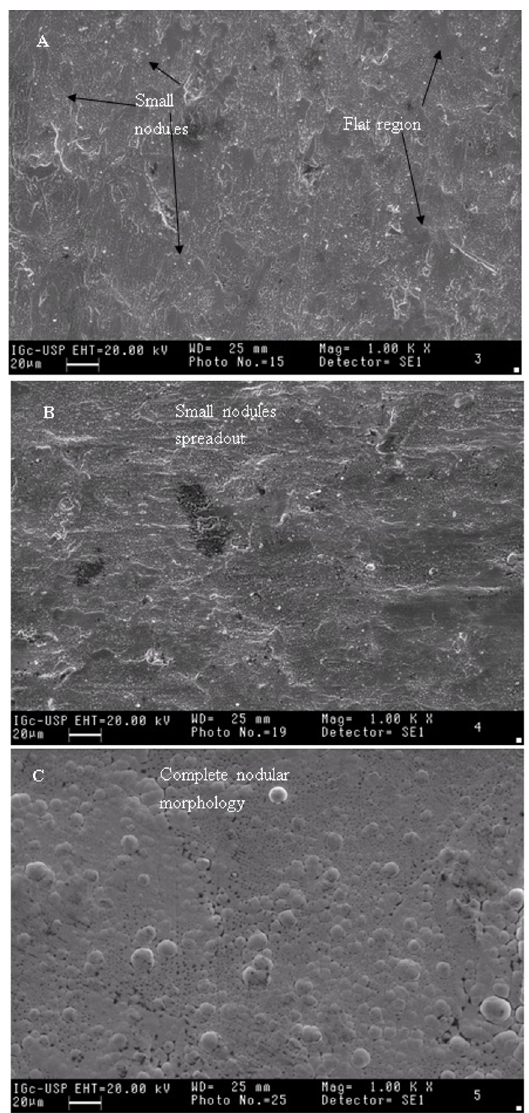
Figure 7. SEM micrographs of the top surfaces of the as-deposited coatings obtained in baths with different tungsten concentrations: a) bath 3; b) bath 4; c) bath